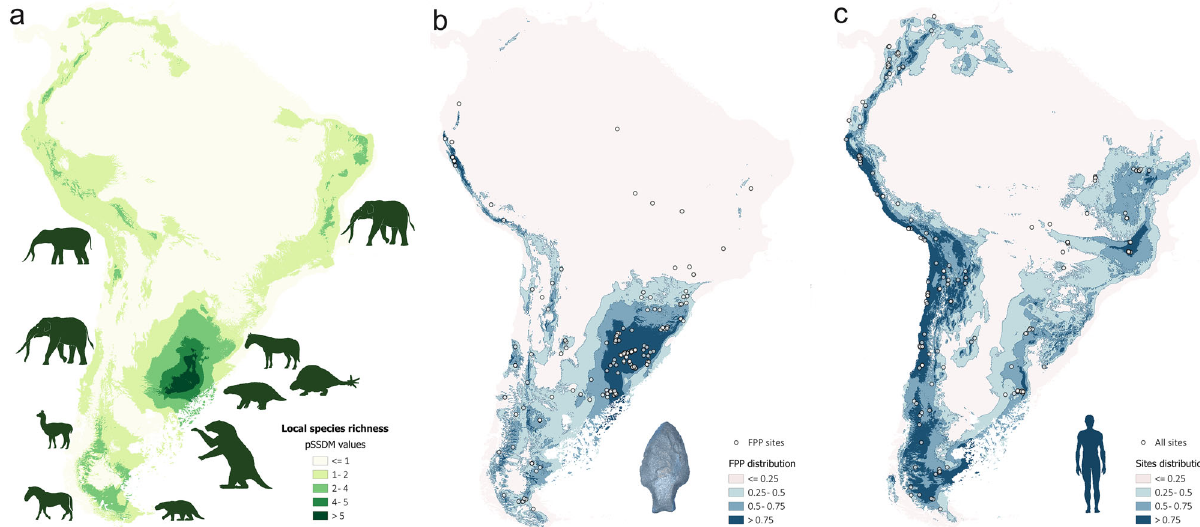
Fig. 6 Spatial distribution of species richness, FPP, and human occupations. Maps describing the local species richness of extinct large mammals (18 k – 9 k cal BP) ( a ), the potential for distribution of Fishtail projectile points (13 k – 10,9 k cal BP) ( b ), and all archeological sites (13 k – 11 k cal BP) ( c ). Local species richness varies from 1 (light green) to >5 (dark green), and the potential distribution of both FPP and all archeological sites vary from 0 (light blue) to 1 (dark